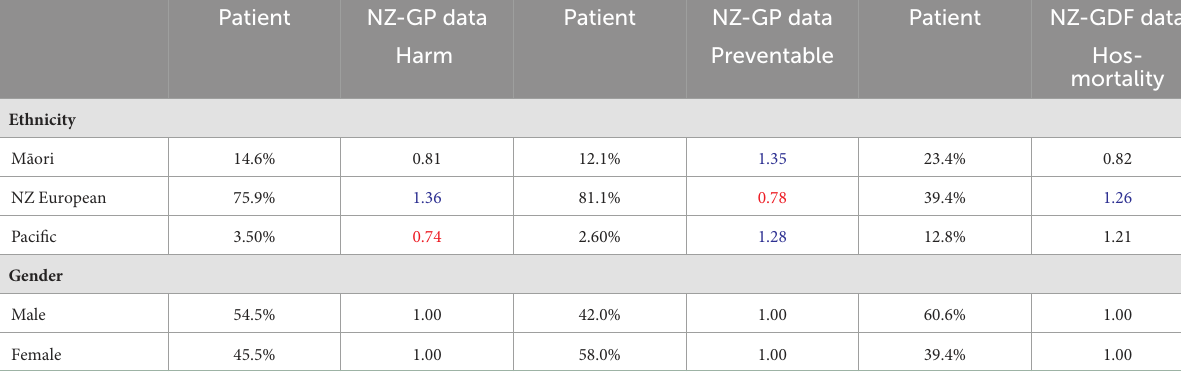
TABLE 2 Disparate Impact (DI) values of NZ-GP Harms data with targets: Harm Status and Preventable Harm Status, and NZ-GDF Data with targets: Hospital mortality. Patient NZ-GP